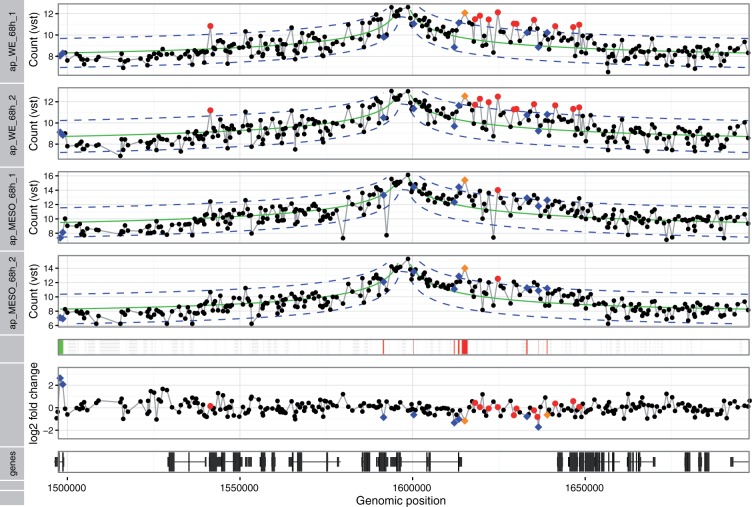
Detection of interactions and differences: The figure shows the plot generated by the FourCSeq to visualize the results. The upper four wide tracks show the variance-stabilized counts for two biological replicates of Drosophila embryo mesoderm tissue and whole embryo 6–8 h after fertilization for the apterous CRM viewpoint. The fit of the distance dependence is shown as solid green line and the dashed blue lines represent the fit ±3σ. Interactions detected by z-score > 3 in both replicates and p-adjusted < 0.01 for at least one replicate are shown as red or orange points. Fragments represented by orange points additionally show a differential interactions (p-adjusted < 0.01, differential Wald test). Differential changes in the contact profile that are not called as interactions are shown as blue points (p-adjusted < 0.01, differential Wald test). The color bar below the 4C profiles shows whether the upper condition (green) or the lower condition (red) has the higher signal for the detected differences (p-adjusted < 0.01). The calculated log2 fold change of the differential testing per fragment are shown above the track at the bottom, which shows the gene model of the region